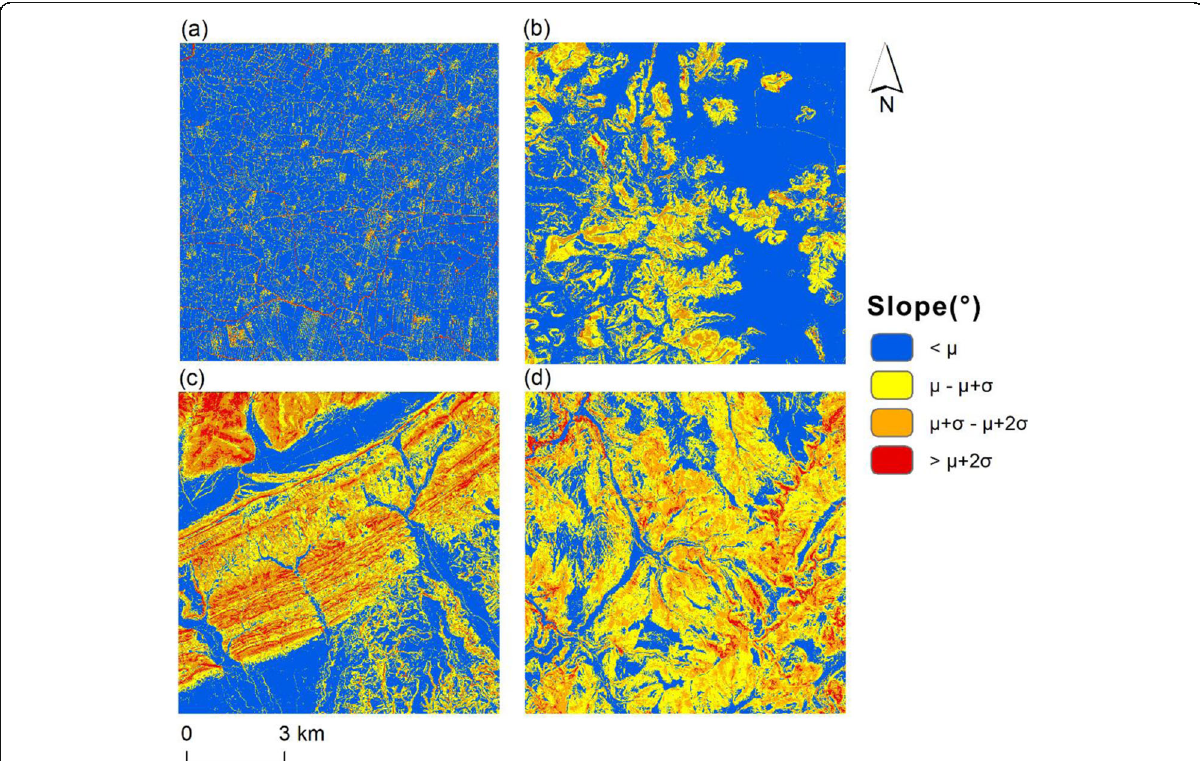
Fig. 5 Slope maps for the four study areas: a floodplain, b plain to hilly, c hilly, d mountain. Slope is colour-coded according to 1 to 2 times intervals of standard deviation σ from the mean